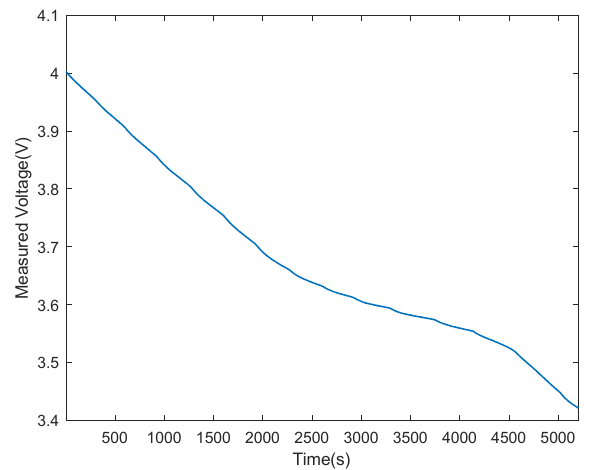
Figure 12. Measured voltage during low-current discharging.